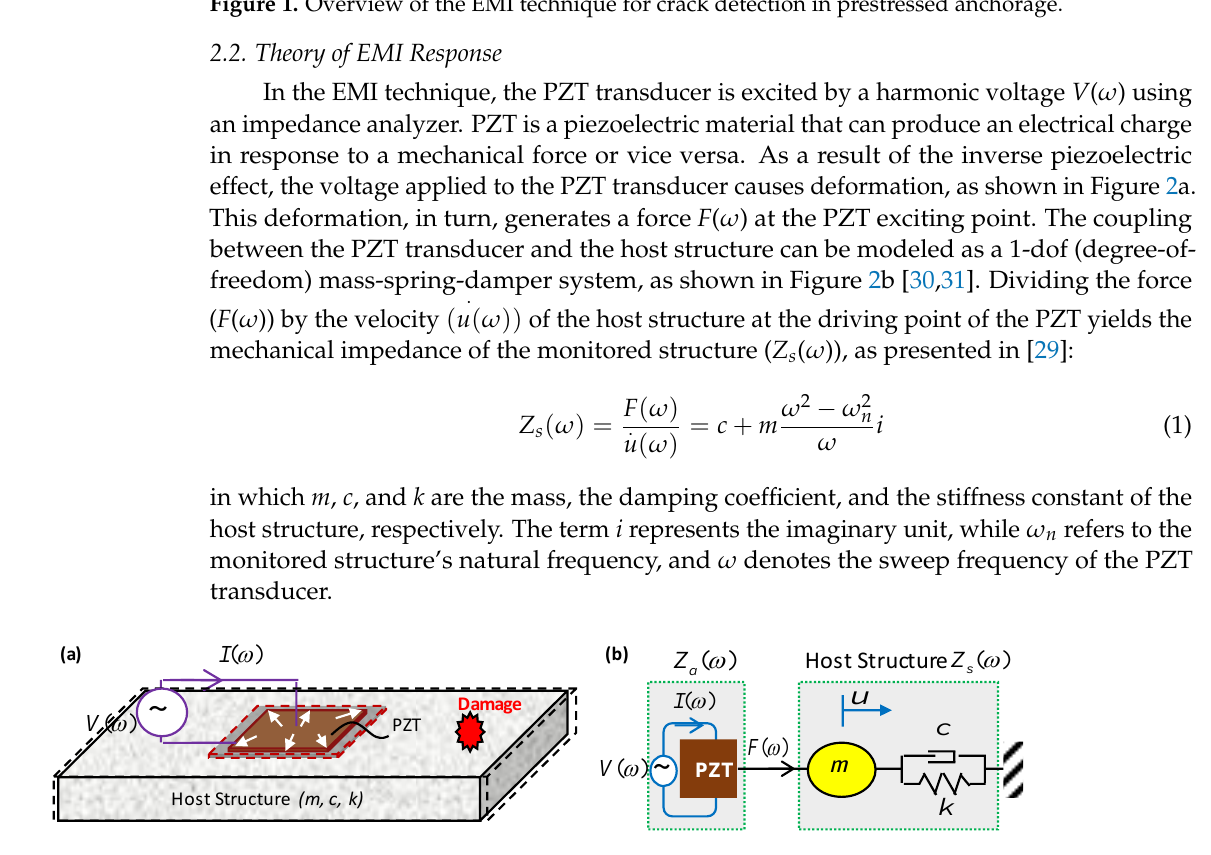
Figure 1. Overview of the EMI technique for crack detection in prestressed anchorage.